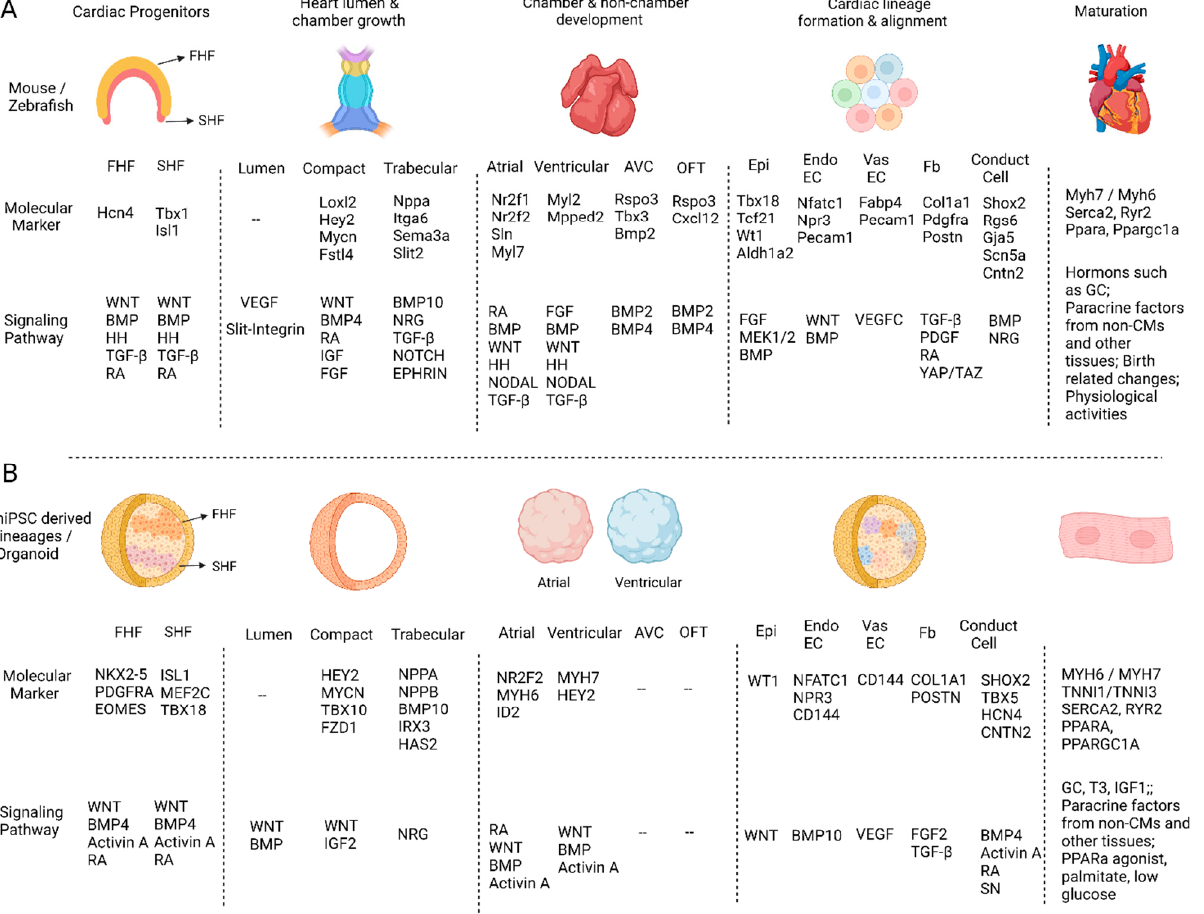
Figure 1. The comparison of molecular markers and regulatory signaling pathways in in vivo heart and human heart organoid development. ( A ) The major events during in vivo heart development and their molecular markers and regulatory signaling pathways. ( B ) The molecular markers and signaling pathways that have been reported to be important in regulating human iPSC-derived car- diac cell or cardiac organoid differentiations. “--” means non-applicable or no related studies have been